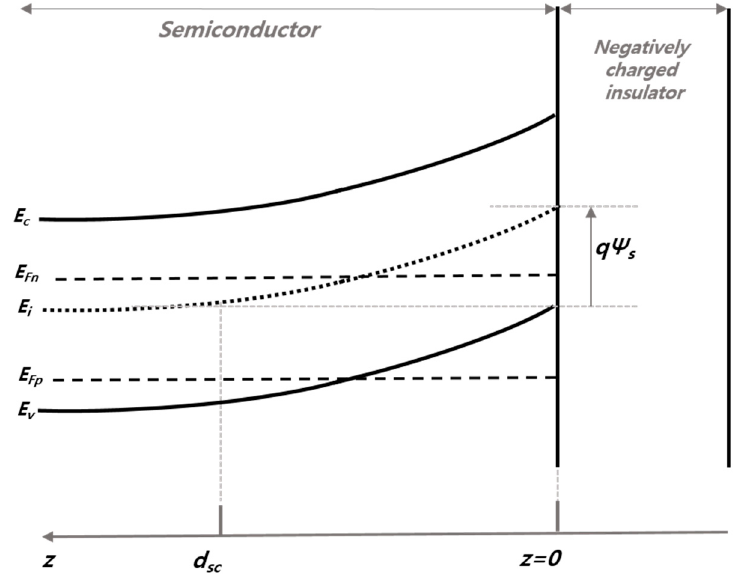
Figure 5. Energy band diagram for a semiconductor–insulator interface under illumination, where the semiconductor is p-type and the insulator is negatively charged (i.e., Al 2 O 3 ). The diagram shows the energy of the conduction band E c , the valence band E v , the intrinsic fermi level E i , as well as the quasi-fermi energy of electrons E Fn and holes E Fp . The distance z = 0 represents the interface between the semiconductor and the negatively charged insulator, and z = d sc represents the distance of the space charge region. Ψ s is the surface potential.